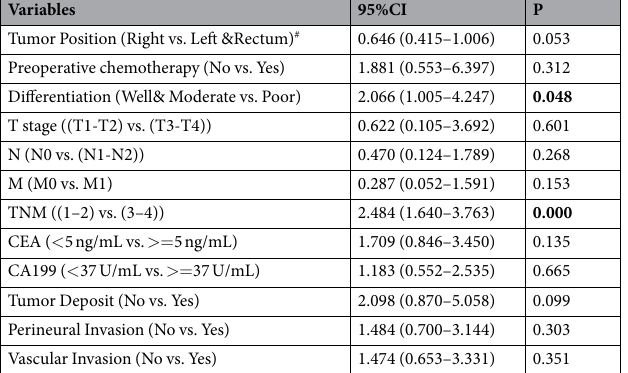
Table 6. Multivariate Analyses of Factors Associated With Progression Free Survival (n = 289). # Right-sided colon cancer vs. Left -sided colon cancer & Rectal